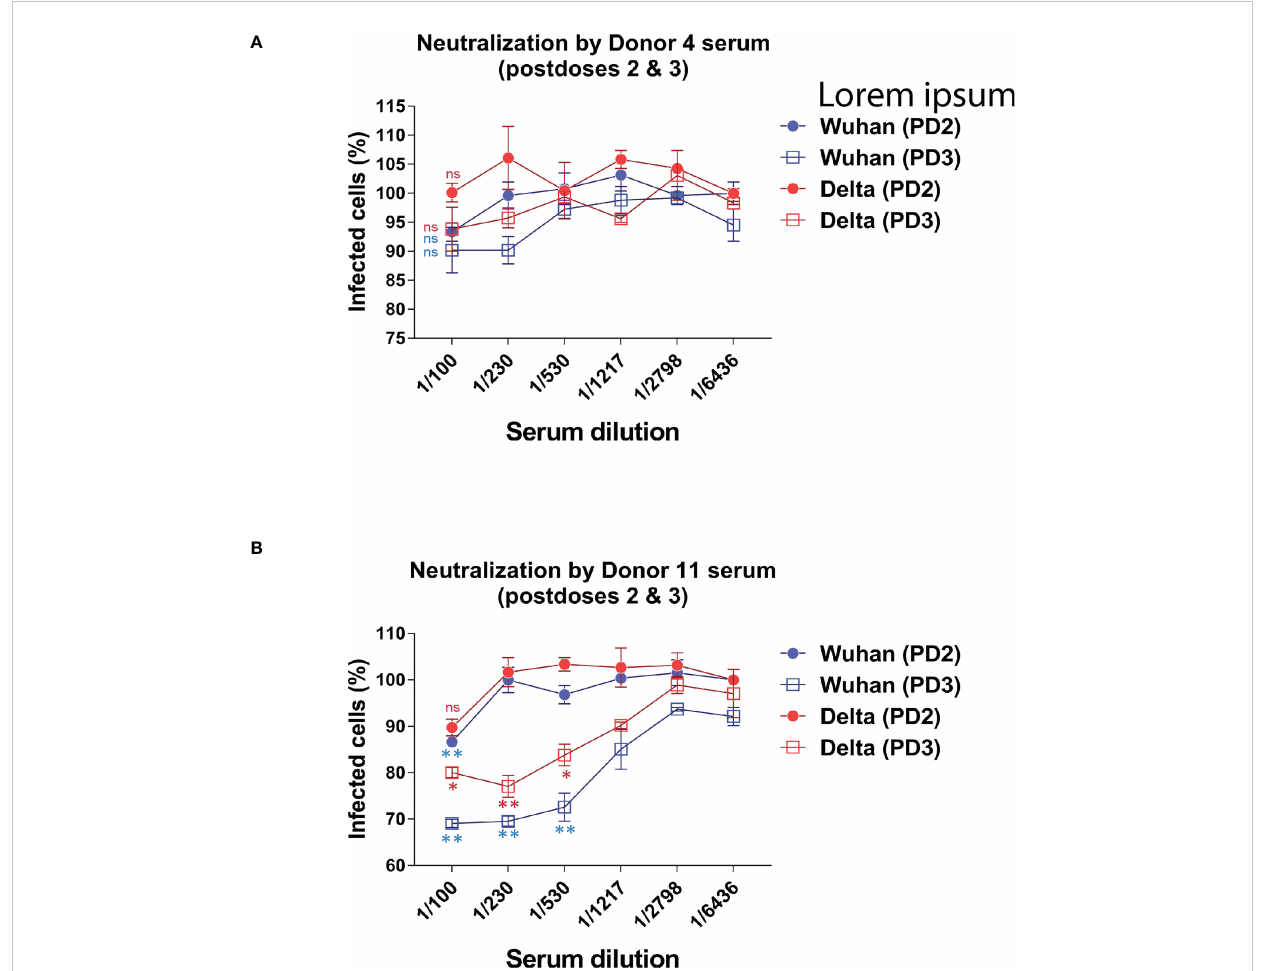
FIGURE 5 Evaluating the ability to neutralize the Wuhan and Delta strains after the second and third doses. The neutralizing capacity of sera from certain volunteers who received the second and third booster of the BNT-P fi zer vaccine was evaluated by comparing their ability to neutralize a GFP+ reporter lentivirus pseudotyped with the S protein of either the Wuhan or Delta strains. The results showed a decrease in the neutralizing capacity against the Delta variant after the third dose compared to the second dose. (A) The neutralizing capacity results against the Wuhan and Delta variants after the second and third dose of BNT are presented for patients #4. (B) The neutralizing capacity results against the Wuhan and Delta variants after the second and third dose of BNT are presented for patients